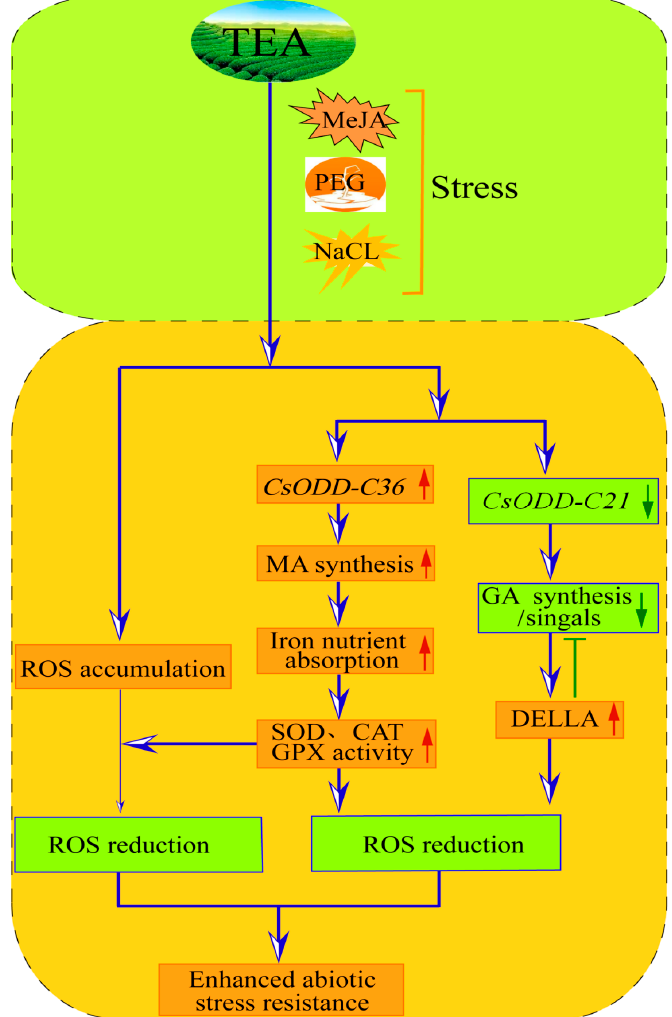
Figure 12. Model describing the Cs2ODD − C36 and Cs2ODD − C21 genes involved in regulating the multi-stress tolerance in C. sinensis.